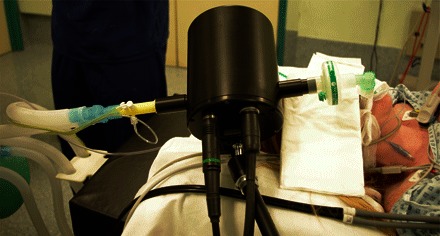
MFS in use during surgery.MFS measurement head incorporated in a closed-loop anesthetic delivery system. A 5-m-long pair of cables connects the measurement head to the control unit located away from the operating table.